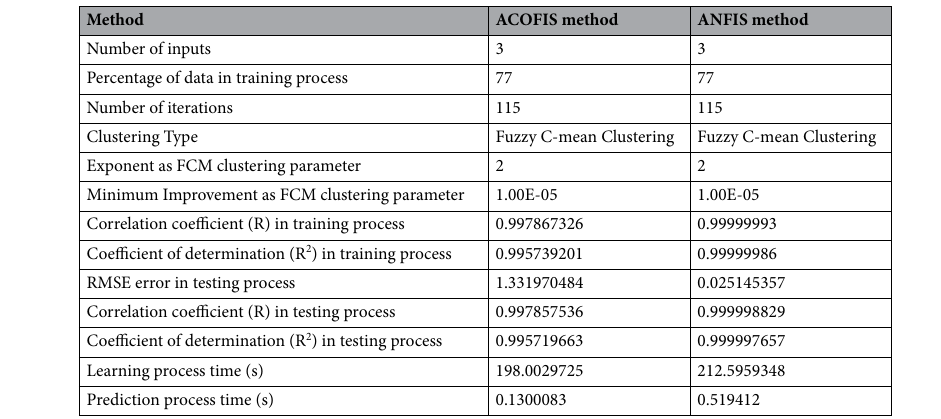
Table 4. Detail of ACOFIS and ANFIS setup and learning